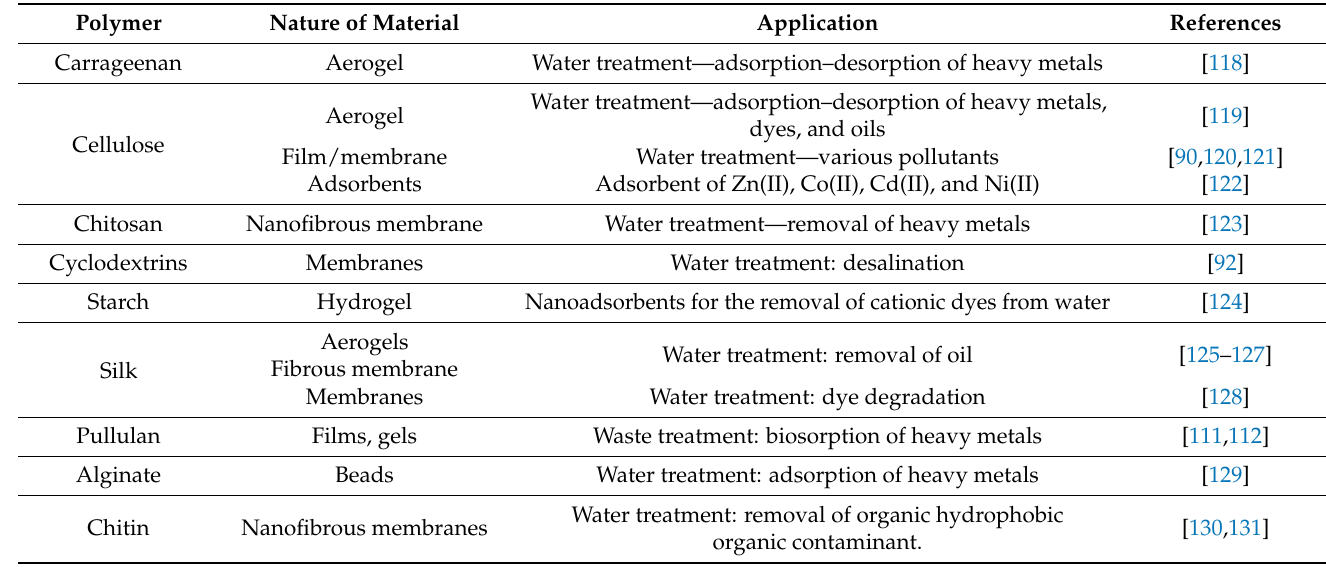
Table 1. Reported applications of biopolymers in water